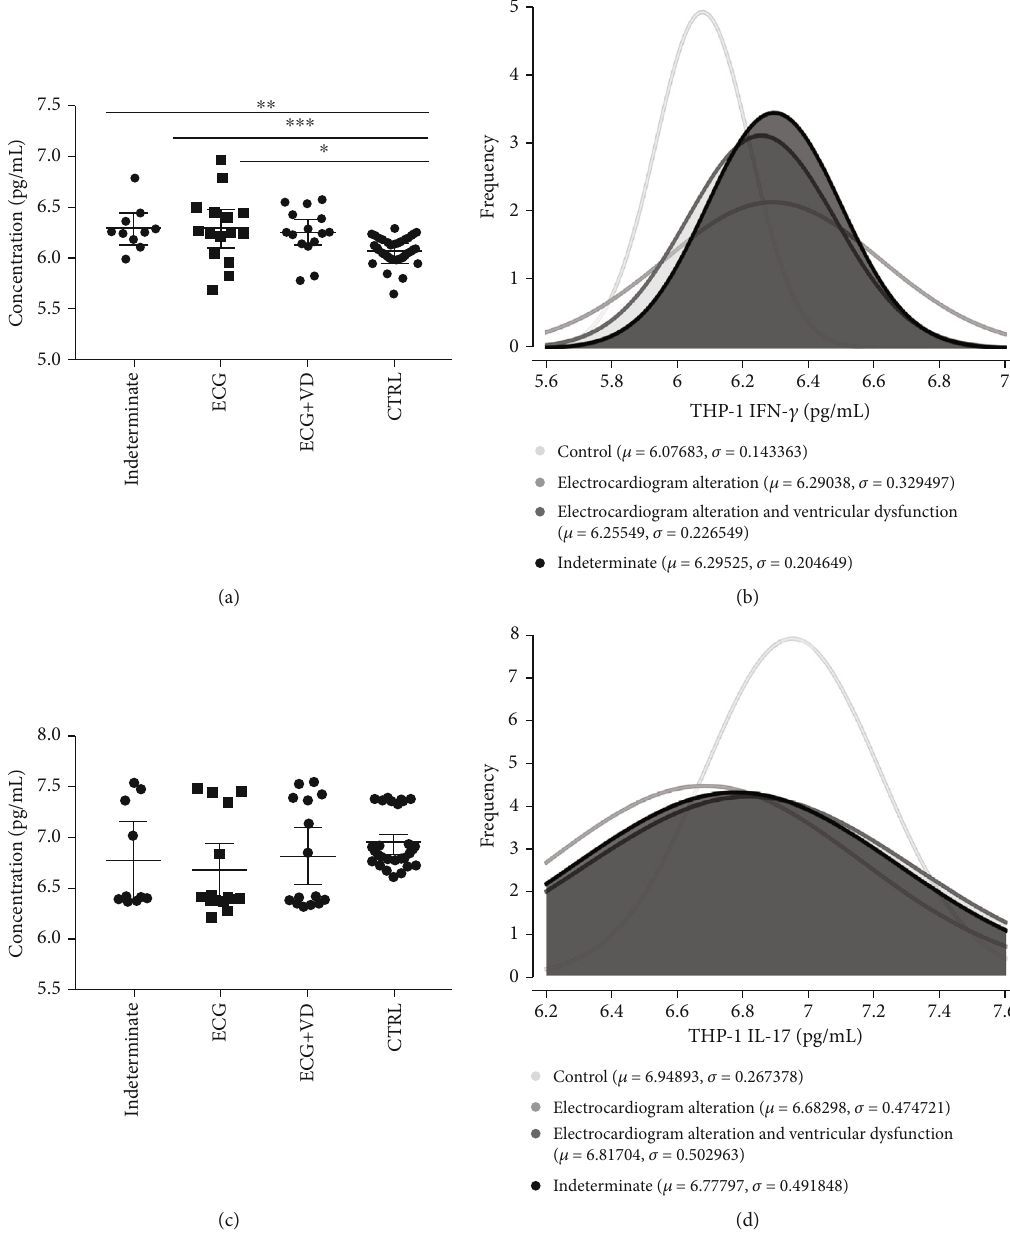
Figure 6: Cytokine production by THP-1 cells (macrophages) quanti fi ed in the supernatant by ELISA after 24 h of stimulation with CCD or CTRL EVs among patients grouped based on the clinical stage of the cardiac burden and controls. (a) IFN- γ concentration in pg/mL ( ∗ p = 0 : 0420 , ∗∗ p = 0 : 0291 , and ∗∗∗ p = 0 : 0118 ). (b) Frequency of IFN- γ concentration values. (c) IL-17 concentration in pg/mL. (d) Frequency of IL-17 concentration